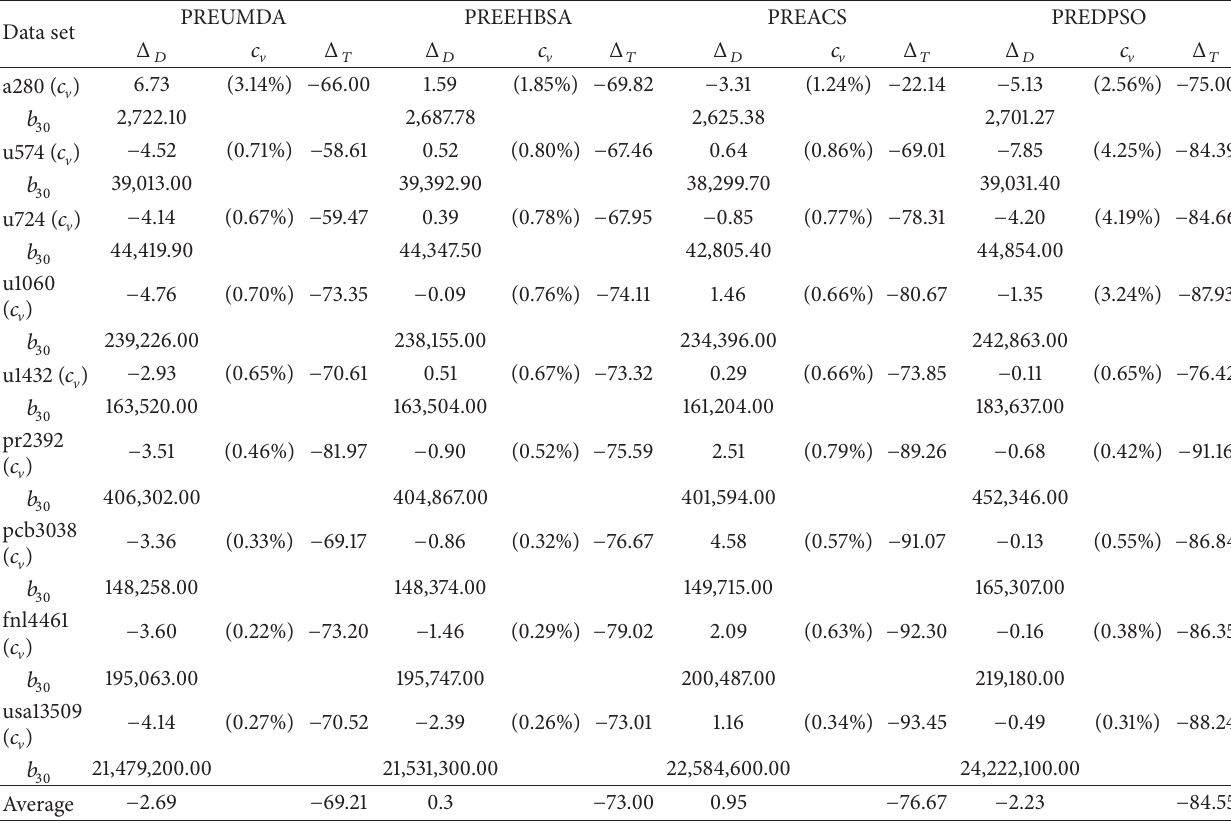
Table 4: Simulation results of UMDA, EHBSA, ACS, and